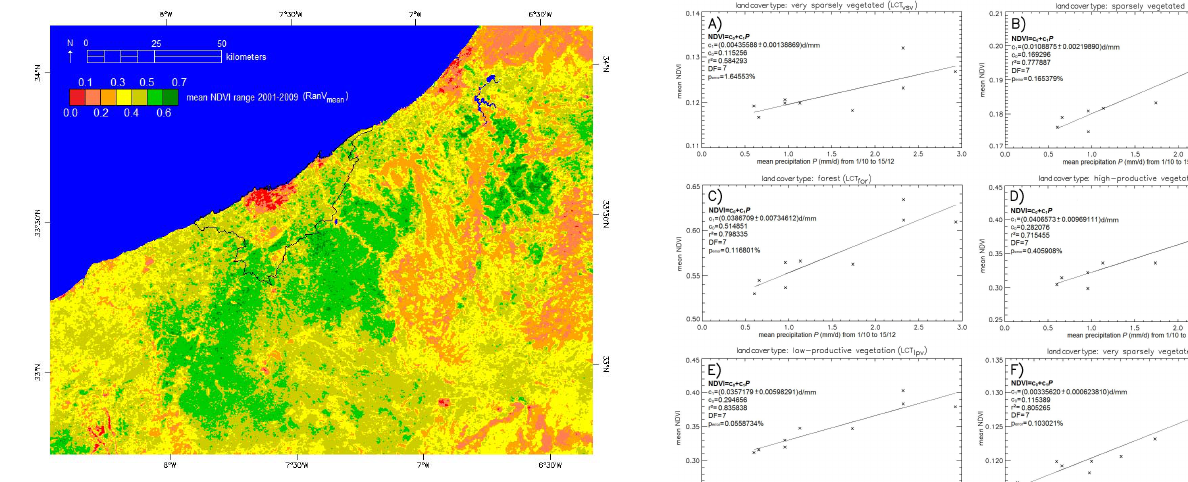
Fig. 11. Mean annual RanV (RanV mean ) for 2001–2009 with marked borders of the administrative region of Grand Casablanca.